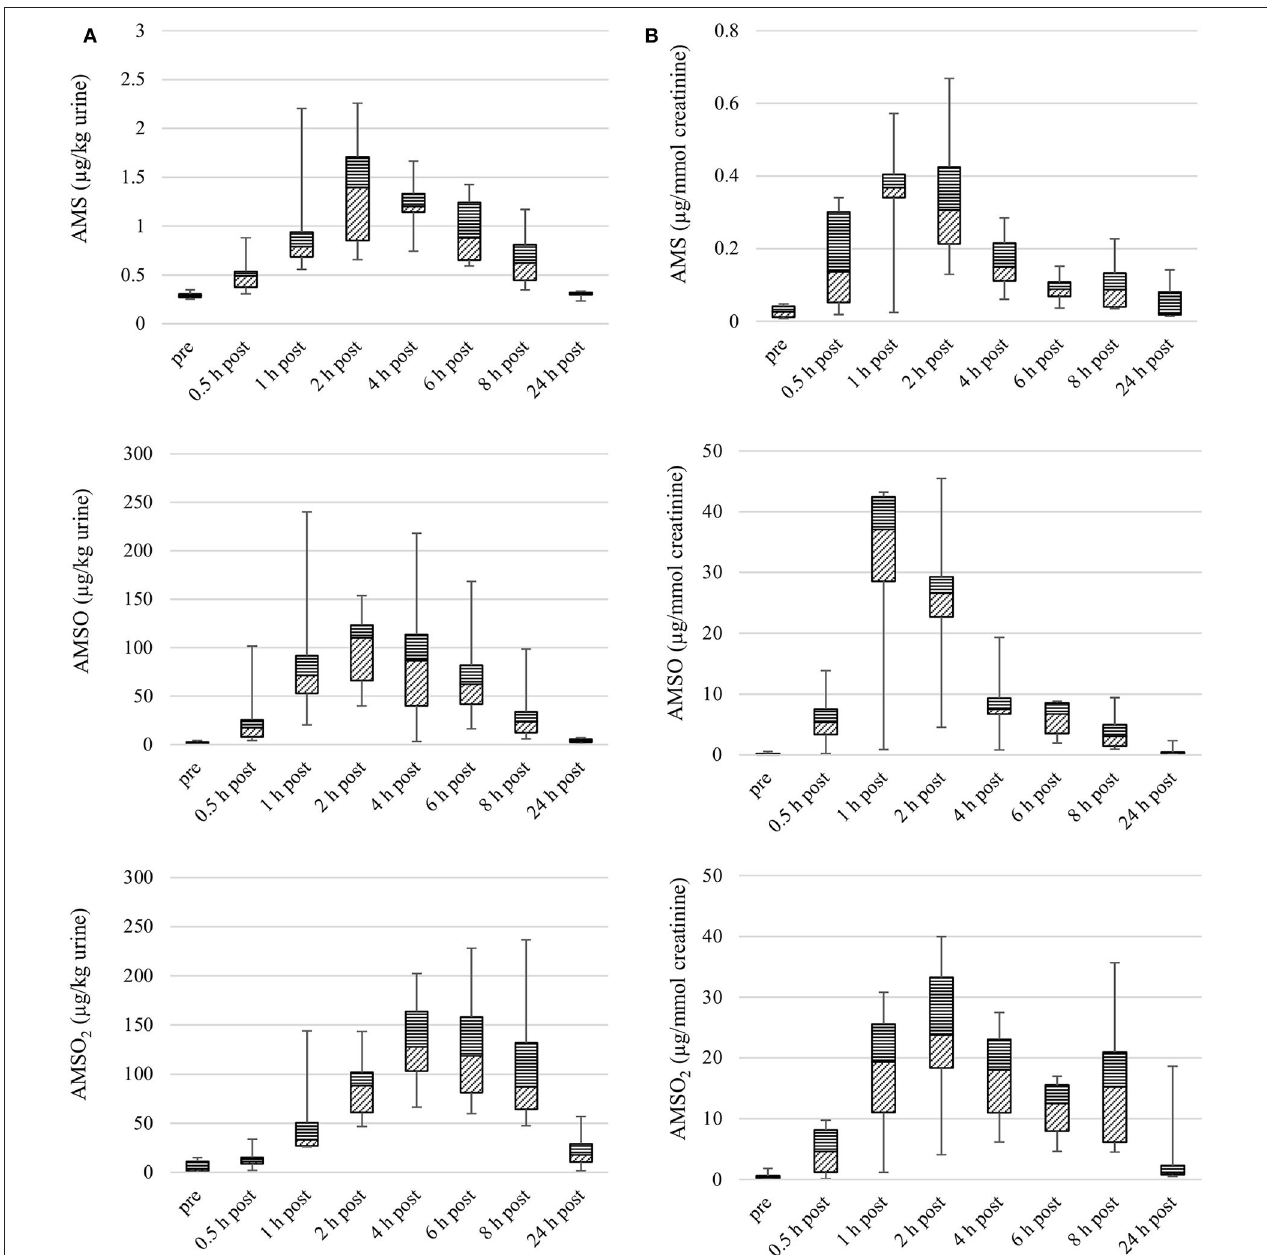
FIGURE 1 | Box plot (median value, markers at minimum and maximum metabolite concentration, box percentile 25–75) of garlic metabolite (AMS, AMSO, and